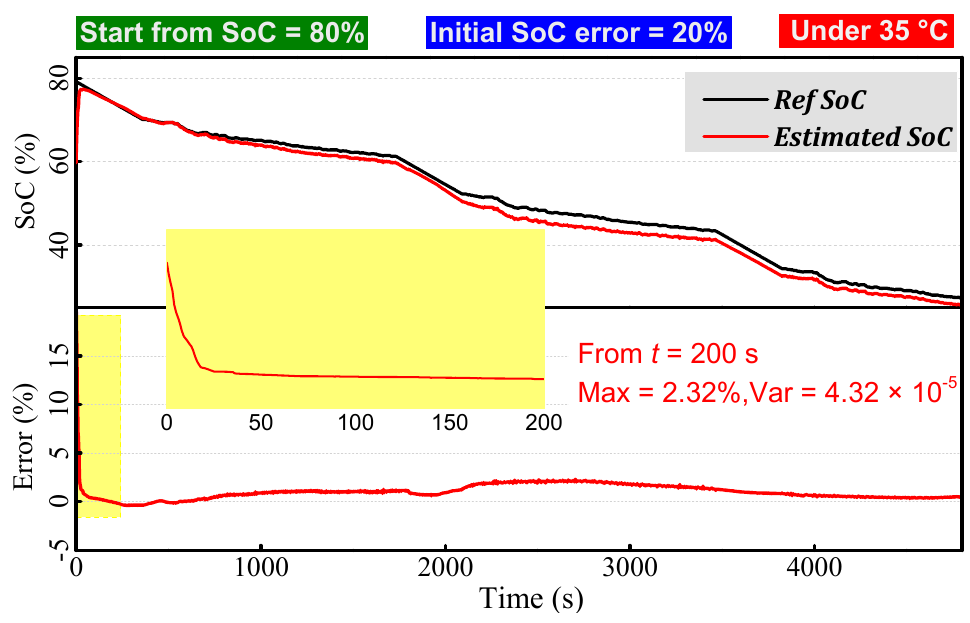
Figure 9. SoC estimation result with − 20% initial error under 35 °C.